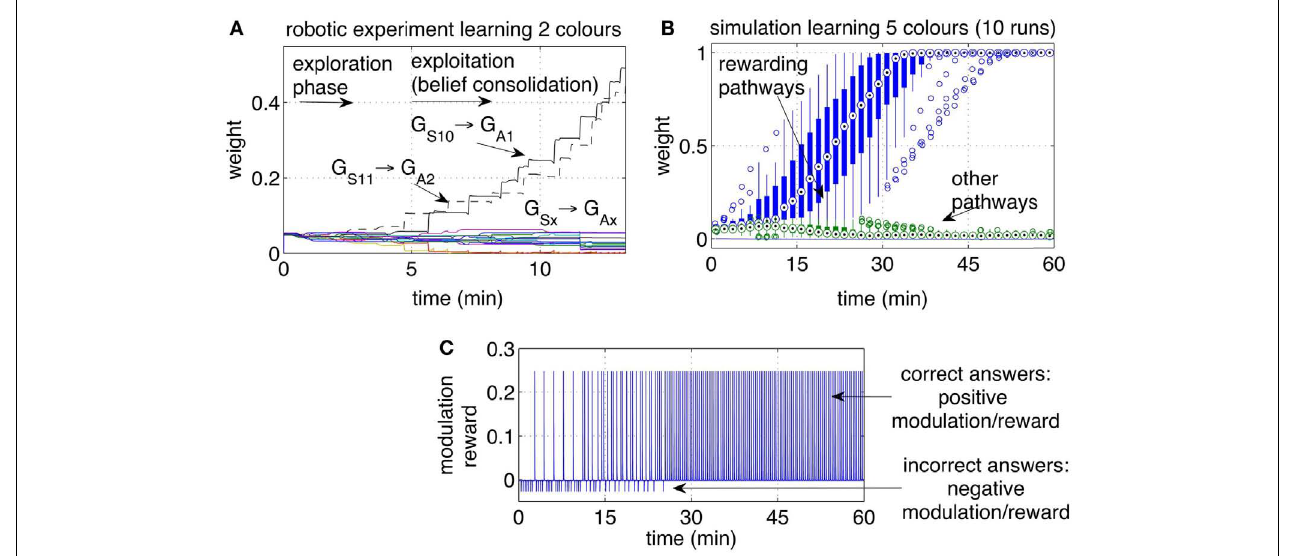
statistical analysis includes 10 independent runs. All correct associations (five colors for each of the 10 runs) were discovered within 30min. All pathways that did not lead to a reward, i.e., the incorrect associations, remained at low values. (C) Modulation while learning five colors. Initially the modulation signal is negative due to negative rewards, a consequence of wrong answers. With time, each of the five color is associated with the correct response. When all answers are correct, all rewarding episodes become